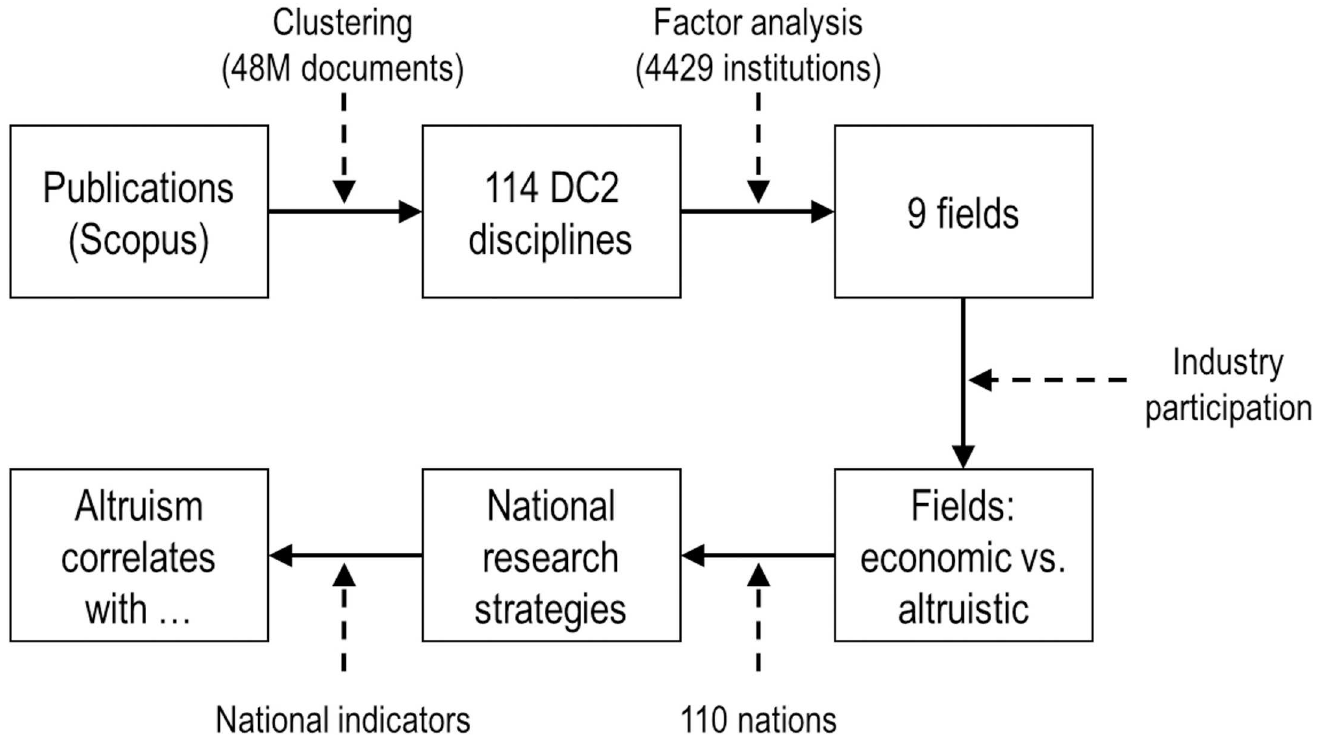
Fig 3. Schematic of study